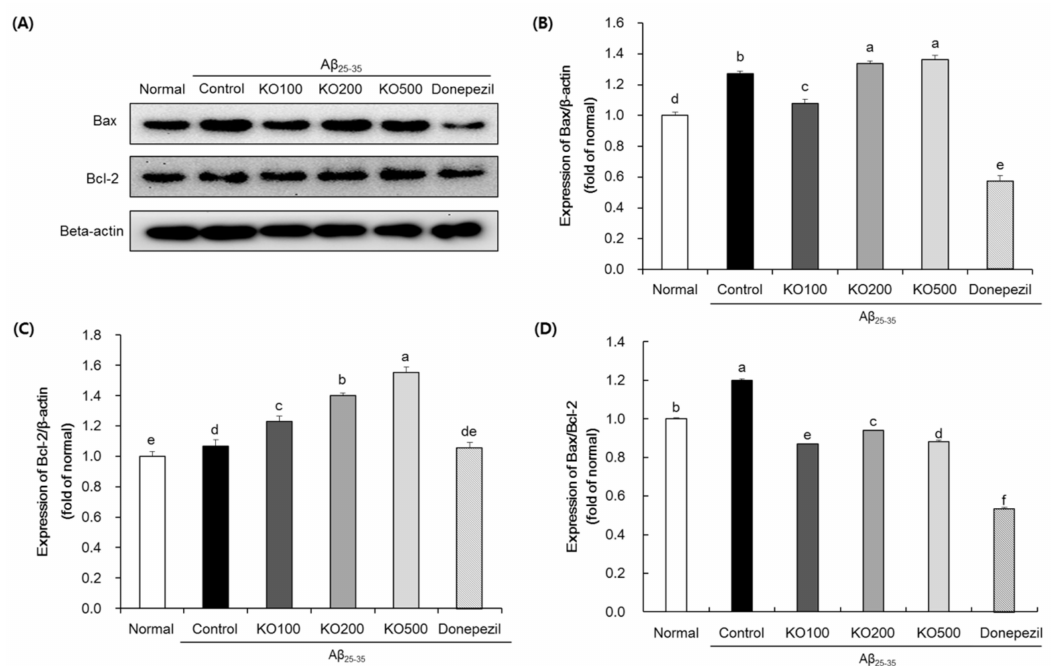
Figure 7. E ff ects of krill oil (KO) on Bax and Bcl-2 protein expressions in the brain. Western blot band ( A ), Bax ( B ), Bcl-2 ( C ), and Bax / Bcl-2 ratio ( D ). Normal, injection of saline solution + oral